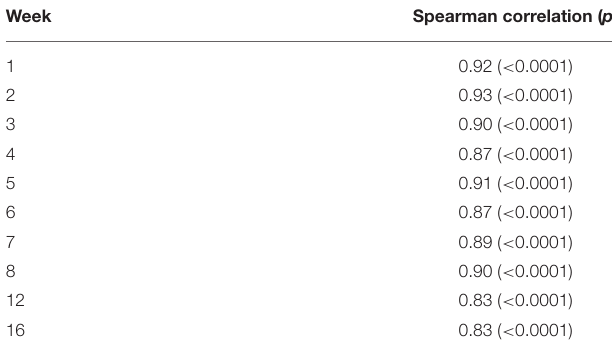
TABLE 3 | Spearman correlations between the Rivermead Post-concussion Symptoms Questionnaire (RPQ) total score and the Sports Concussion Assessment Tool (SCAT) total score by week administered.